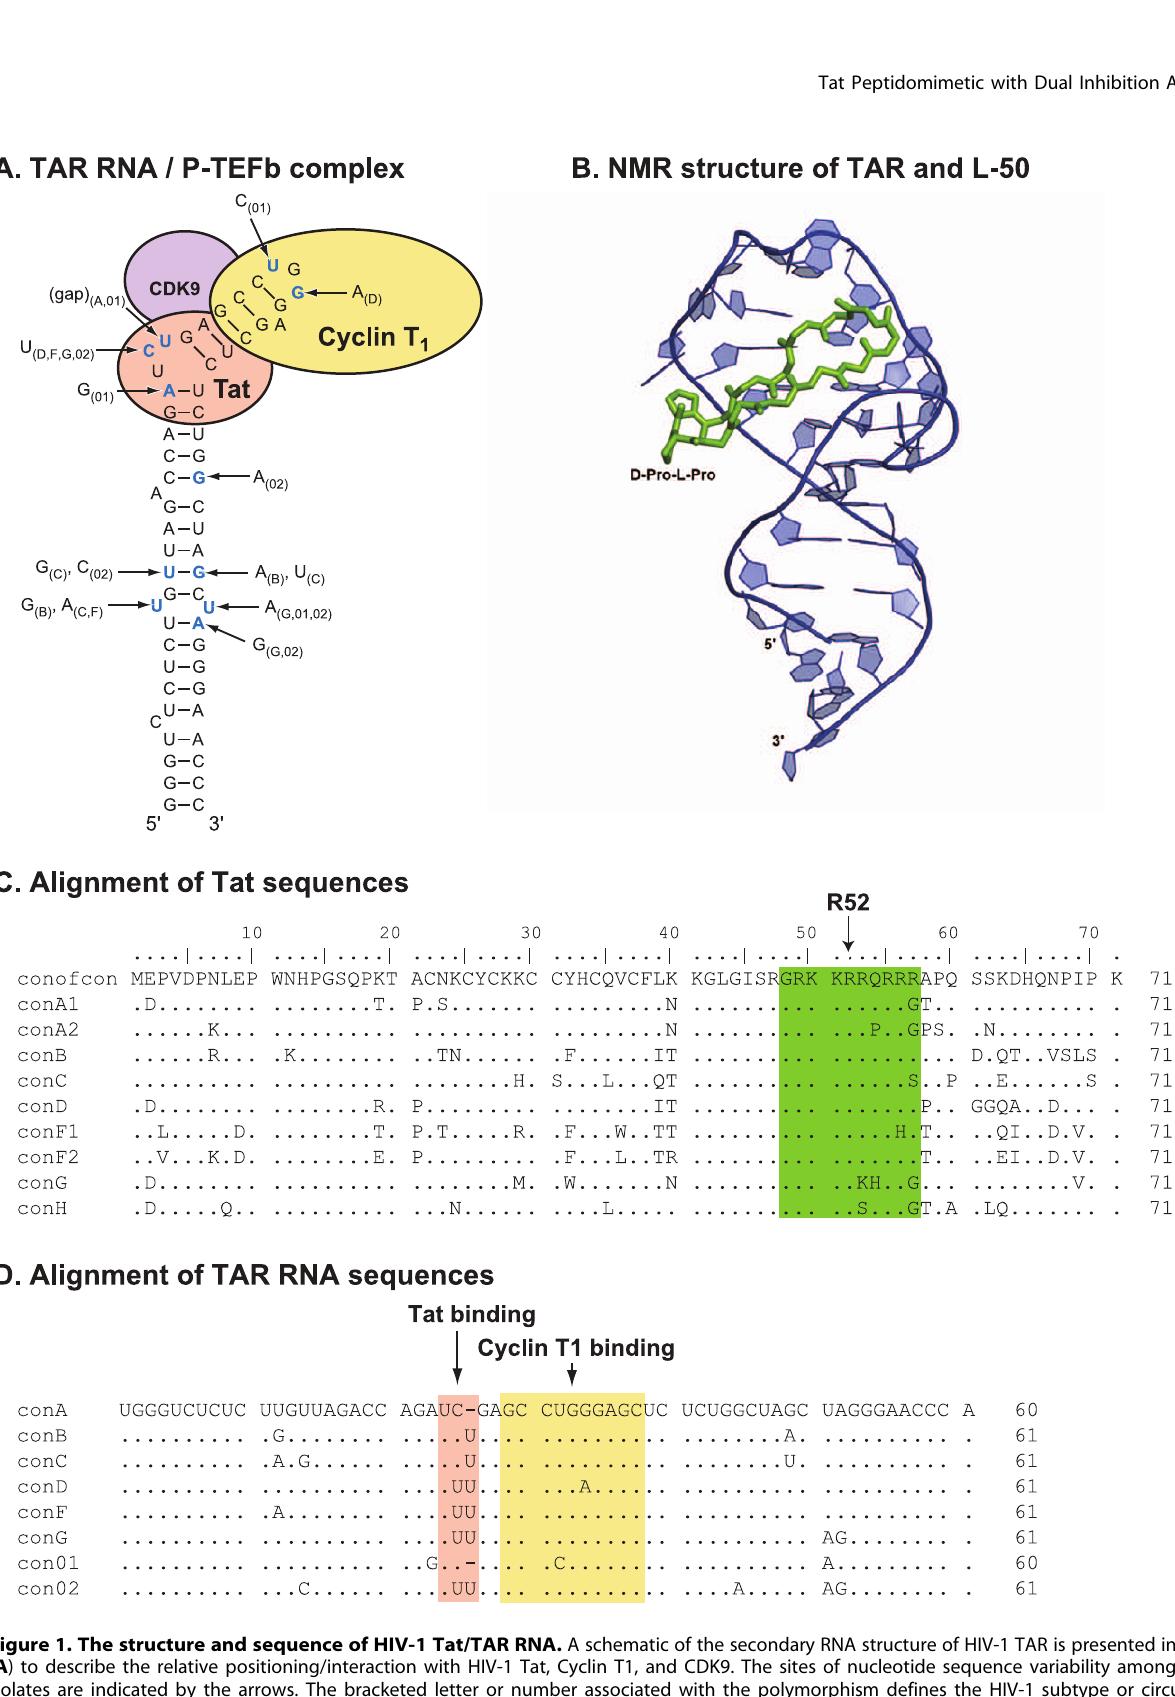
PLoS Pathogens | www.plospathogens.org